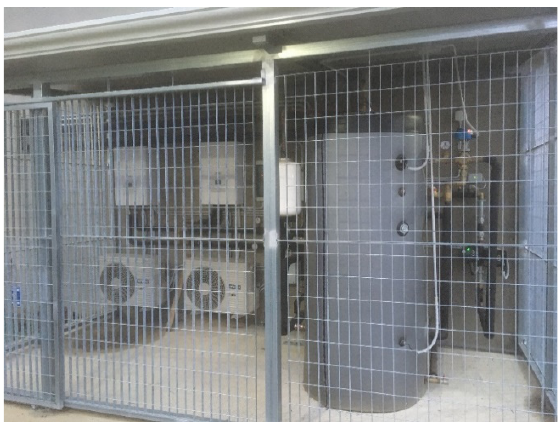
Figure 2. Heat pumps with external units installed on the vertical wall (on the left) and an insulated vertical storage tank used in the demonstrative air-conditioning plant.